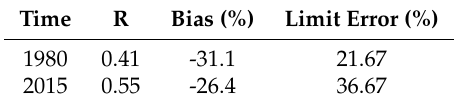
Table 13. Analysis of PM 2.5 concentration simulation results using 1980 and 2015 land-use